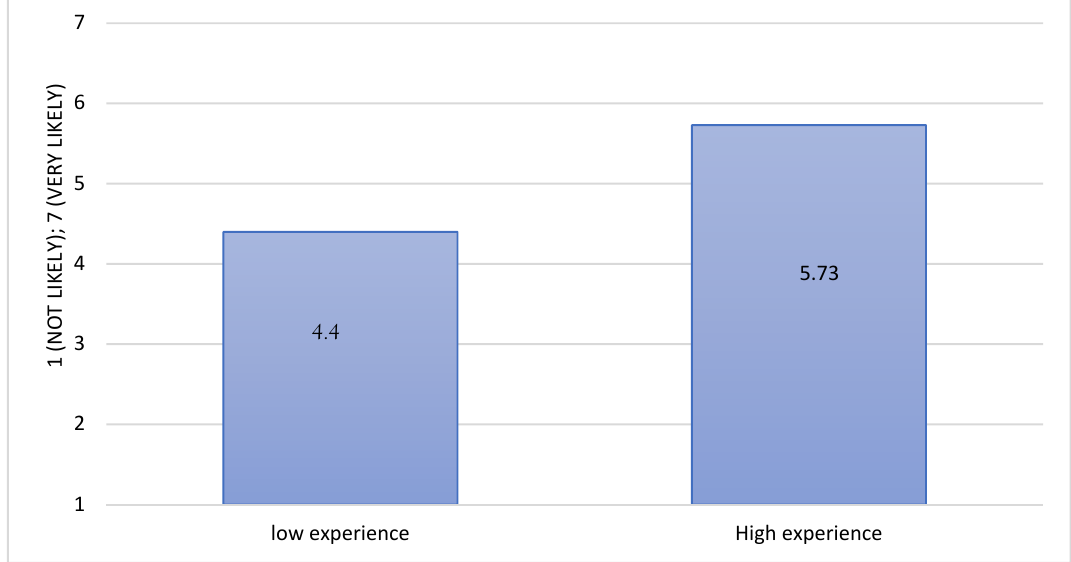
Figure 11. Probability of adopting agroecological practices in the future based on farmers’ experience with agroecological practices.